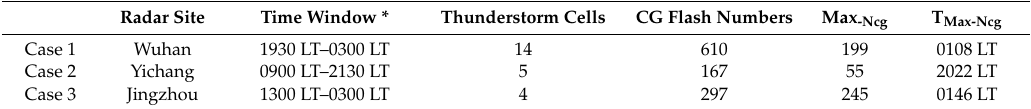
Table 2. Identification of thunderstorm cells in three strong convection period based on Thunderstorm Identification, Tracking, Analysis, and Nowcasting (TITAN). The time window includes the peaks of lightning and precipitation (red box in Figure 2). Max -Ncg is the maximum number of CG flashes produced by a thunderstorm cell per minute. T max-Ncg is the time of Max -Ncg .